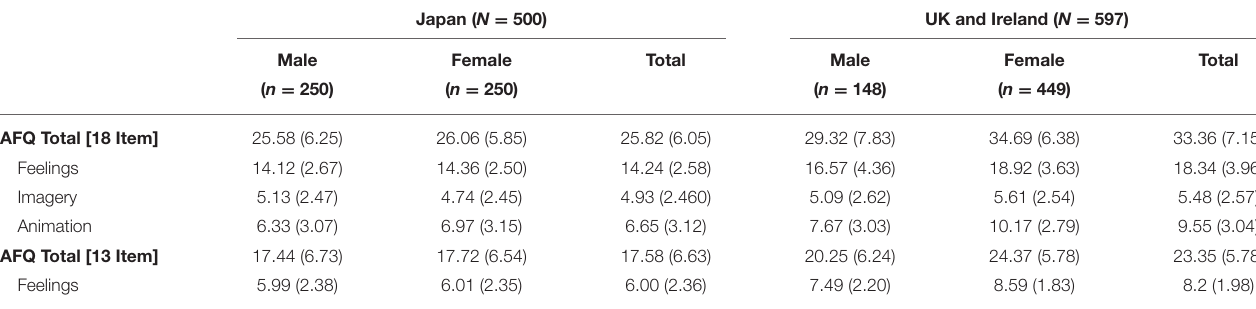
TABLE 3 | Mean and standard deviations of AFQ scores by cultural group and gender.